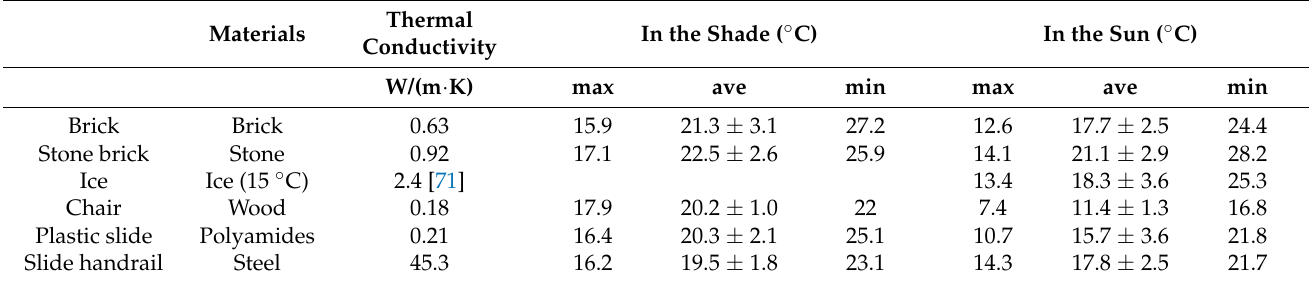
Table 9. Cold risk thresholds for hand contact with different materials